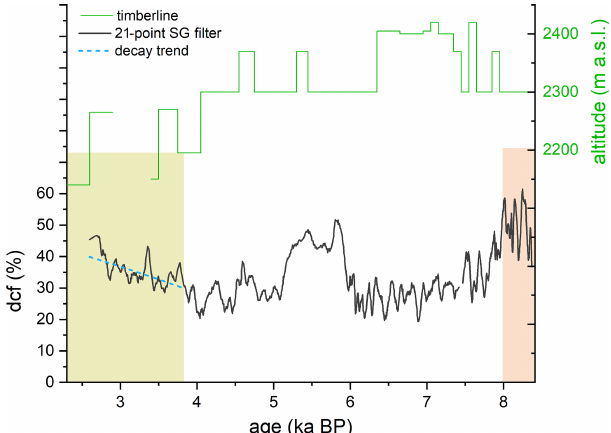
Figure 5. Comparison of the dcf in stalagmite SPA 127 with the el- evation of the timberline reconstructed for the Kauner valley 70km west of Spannagel Cave (green line, after Nicolussi et al., 2005) with the dcf. Around 4ka the timberline started to decline, which is concurrent with an increase in dcf, i.e., a decrease in initial 14 C. This decrease closely follows a radiocarbon decay trend (dashed blue line). Green and red areas mark the three different time periods as indicated in Fig.